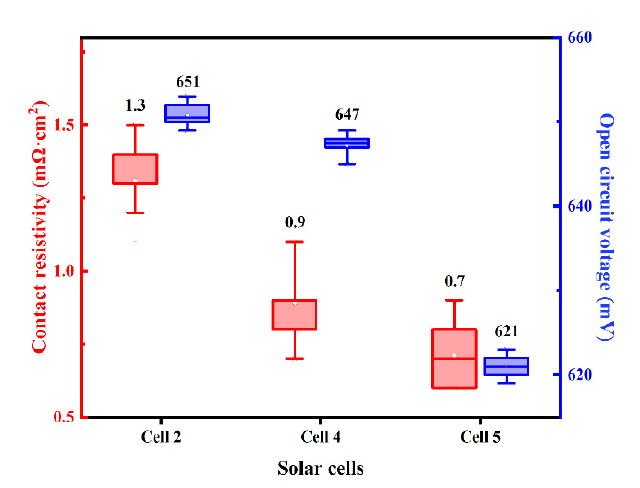
Figure 13. The distribution of the ρ c and V OC of the solar cells using the firing-through Al paste within different particle size Al powders.